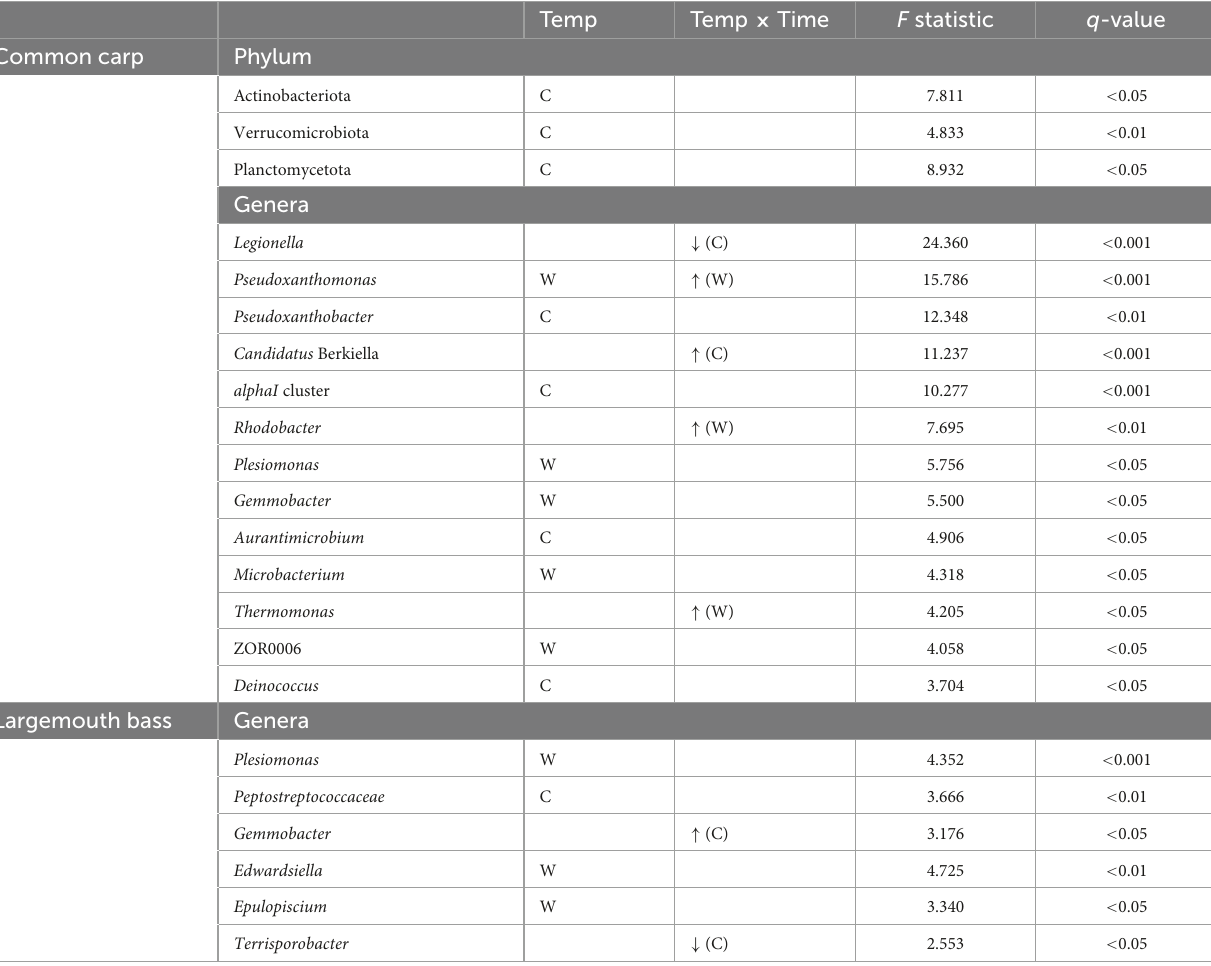
TABLE 1 Bacterial phyla and genera in common carp and largemouth bass gut microbiota which had relative abundances that were significantly affected by temperature or the interaction of temperature and